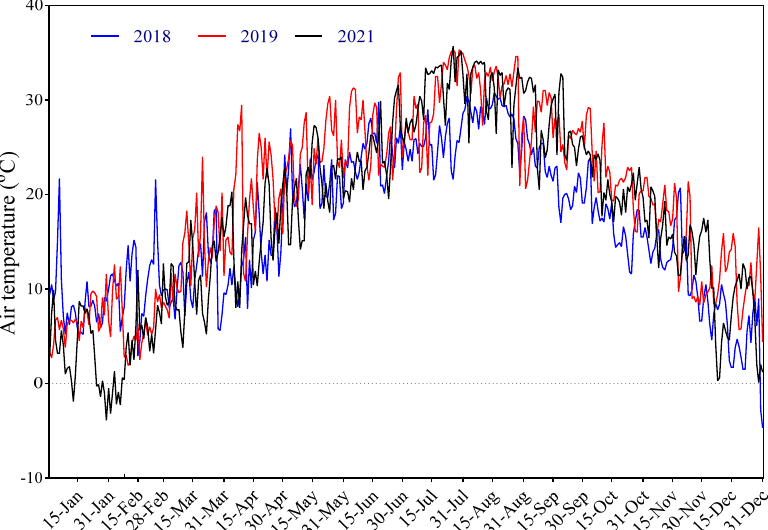
Figure 9. Air temperatures in the garden field in Hangzhou during the growing seasons in 2018– 2021. Temperatures were recorded hourly in the field using a GM200-TH temperature and humidity recorder (Zhituo Instruments Limited Company, Hangzhou, China).